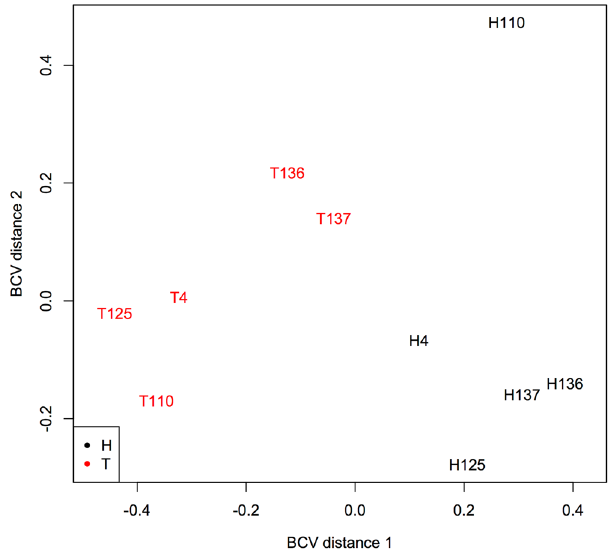
Figure 1. Principal component analysis of the 500 most variable miRNAs in the tissue samples (healthy tissue - H and tumor tissue - T) from five patients diagnosed with